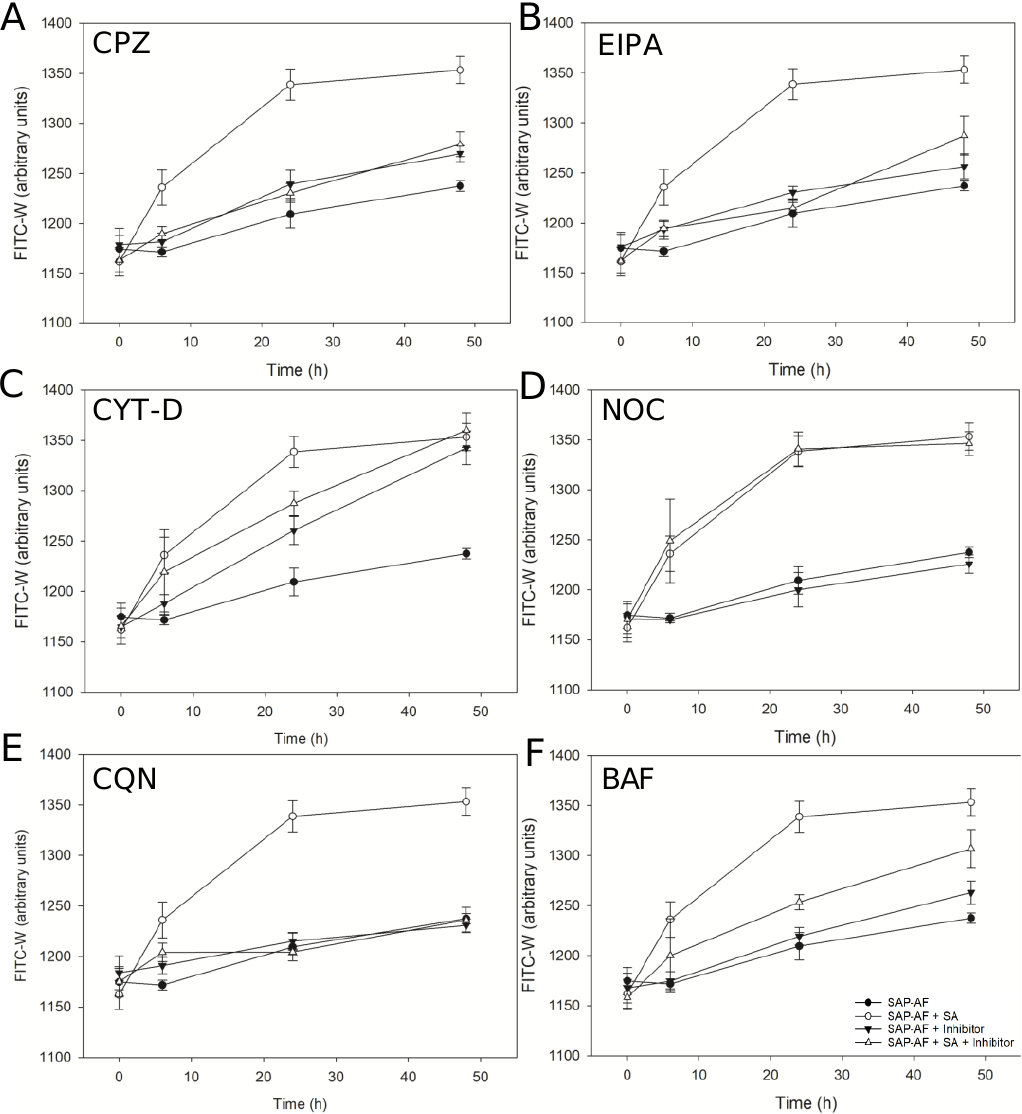
Figure 2. Investigation of the inhibition of SA mediated endolysosomal escape of SAP-AF in Daudi cells by pharmacological agents as measured by pulse width analysis. The effect of chlorpromazine ( A ), EIPA ( B ), cytochalasin D ( C ), nocadazole ( D ), chloroquine ( E ), and bafilomycin A1 ( F ) on the SA mediated endolysosomal escape of SAP-AF in Daudi cells. Charts show the changes in FITC-W over time in cells treated with 1 µg/mL of SA in the presence ( △ ) and absence ( ○ ) of inhibitor. Untreated control cells are shown in each chart for comparison in the presence ( ▼ ) and absence (●) of inhibitor. Each datum point represents the calculated mean of three separate experiments, each performed in duplicate, and error bars one standard deviation either side of this mean.